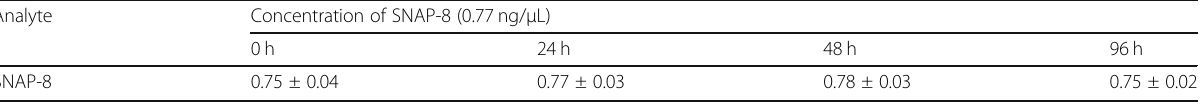
Table 4 Stability test of SNAP-8 in DW at 4 °C